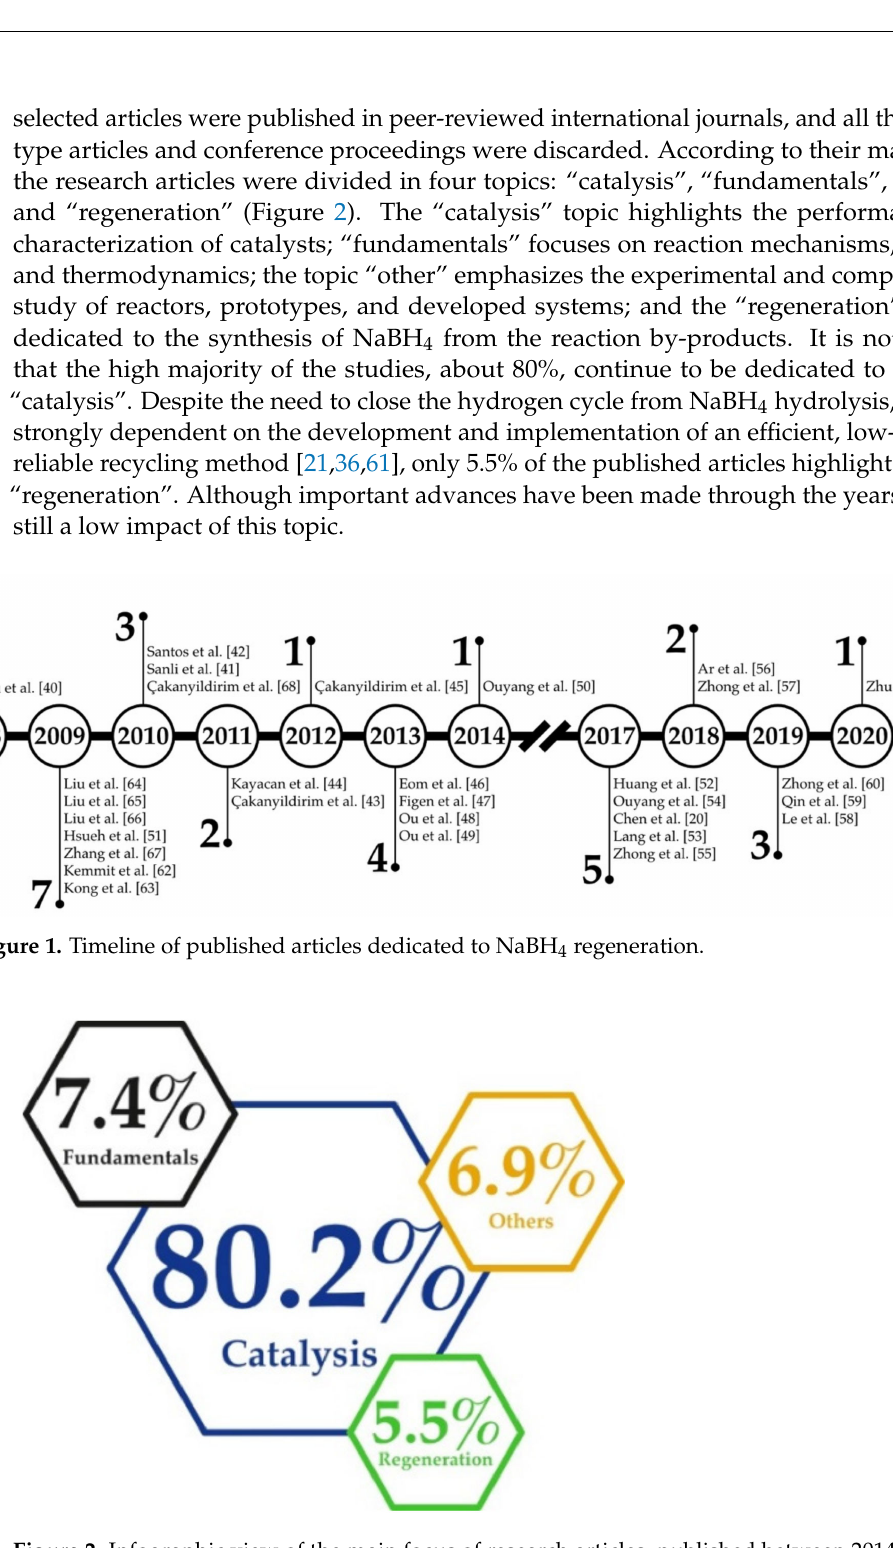
Figure 2. Infographic view of the main focus of research articles, published between 2014 and 2021, dedicated to the regeneration of NaBH 4